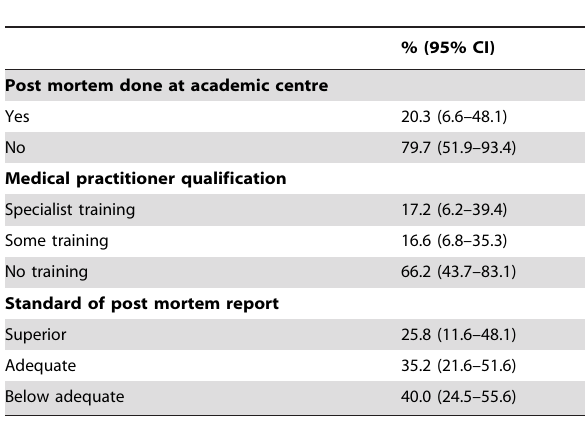
Table 1. Frequency distribution of forensic pathology services: all cases (weighted